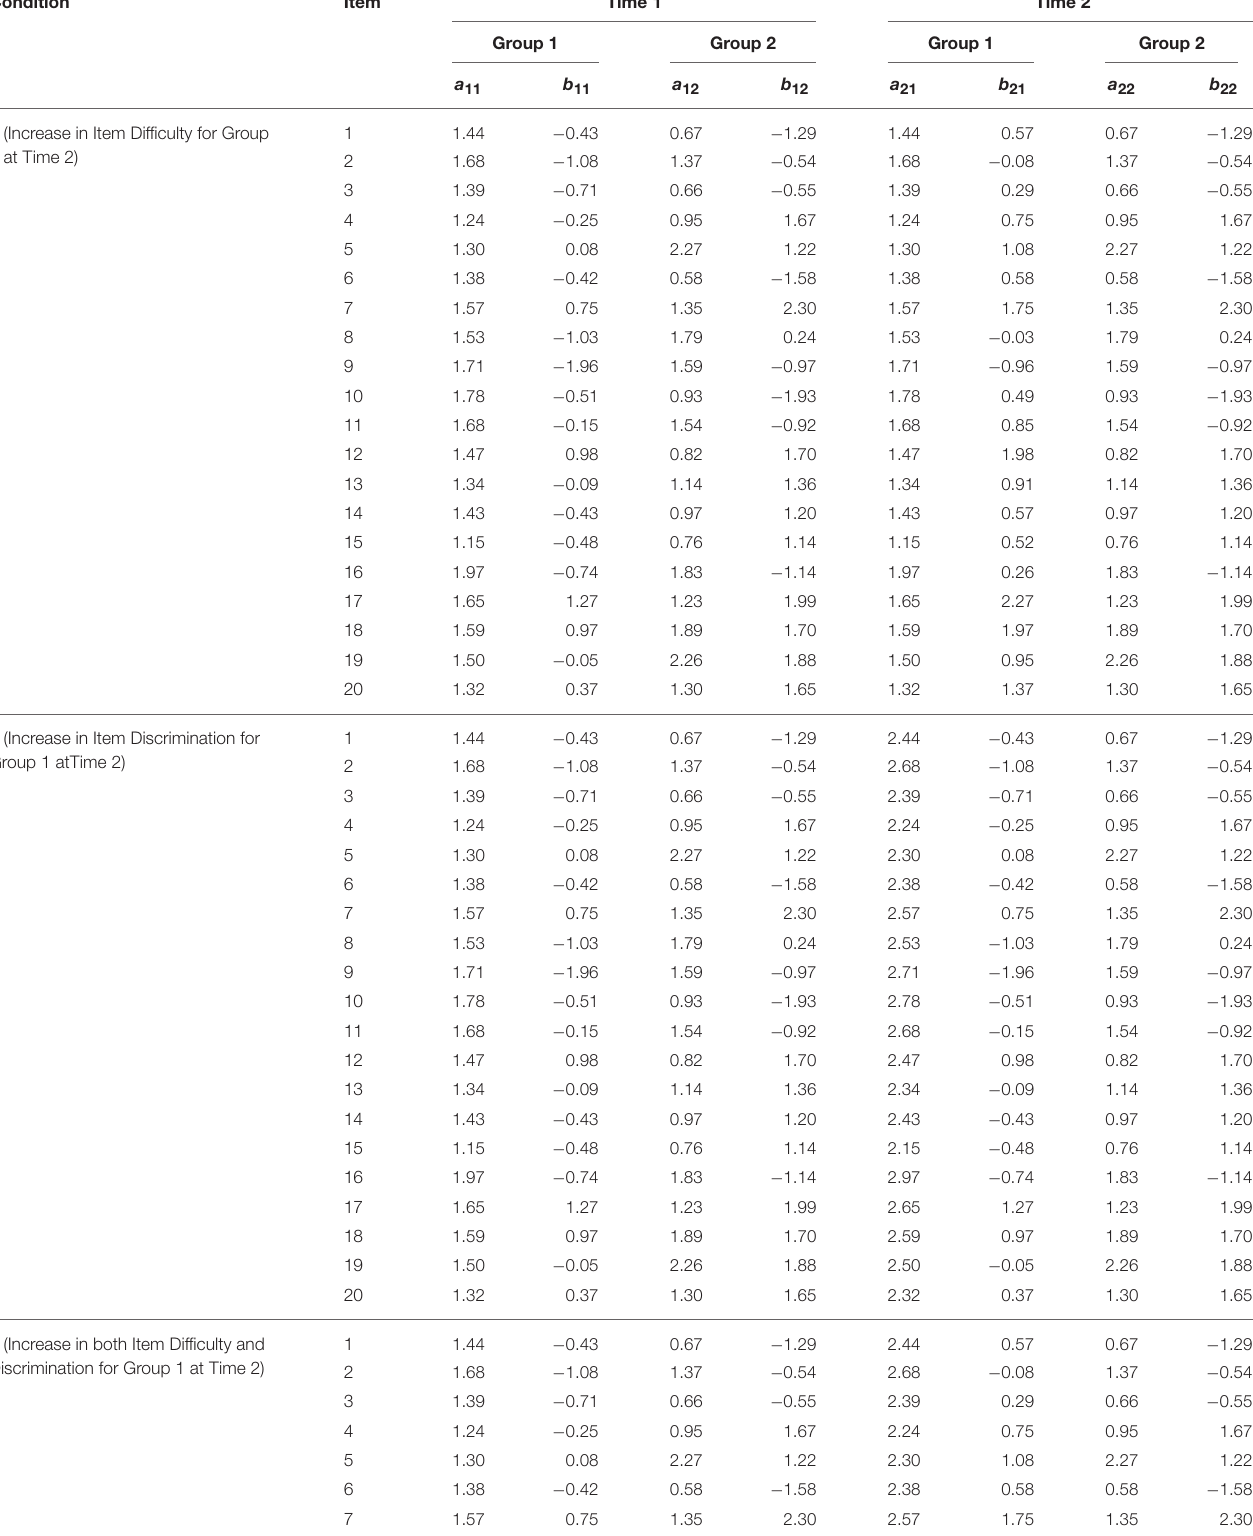
TABLE 5 | Conditions for the simulation study: generating values. Condition